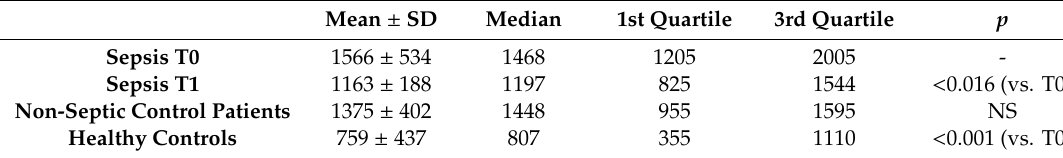
Table 5. Levels of platelet-derived microparticles (annexin +/ CD61 +/ PF4 + ) in patients with sepsis, on admission (T0) and at 7 ± 2 days afterwards (T1), and in control patients with acute non-septic disease, and healthy